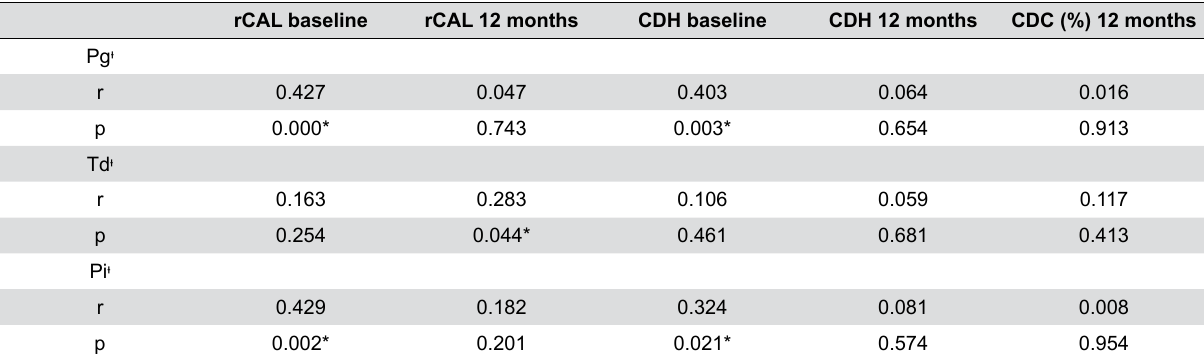
Table 3- Correlations between the changes in counts of DNA copies of Pg, Td and Pi (copies/µl) and the rCAL, CDH and CDC (%) values at baseline and 12 months